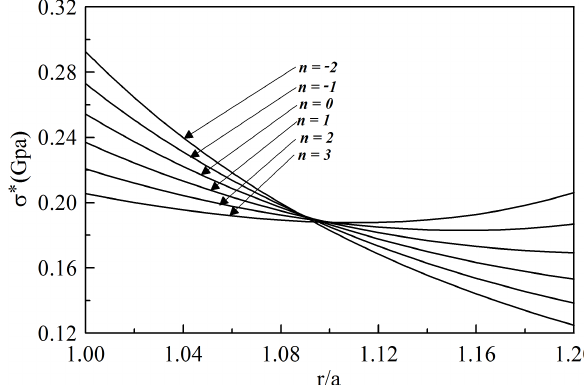
Figure 37: Radially distributed displacement